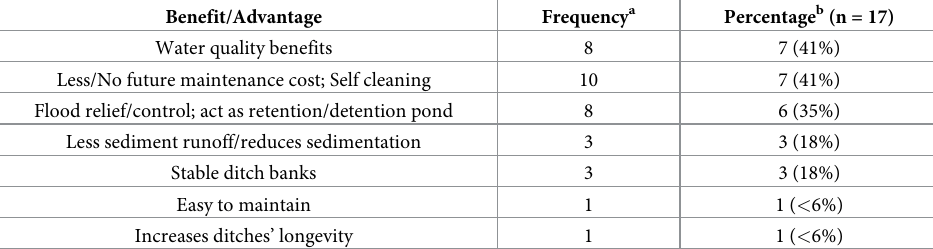
Table 1. Advantages associated with two-stage